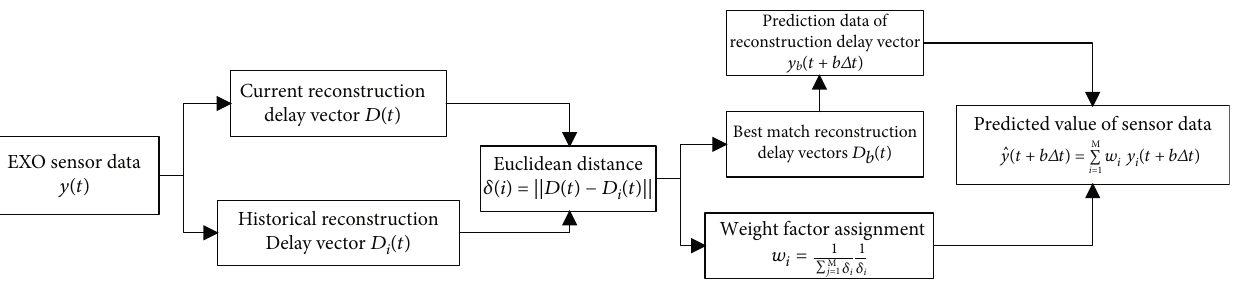
Figure 2: Flow chart of the Takens